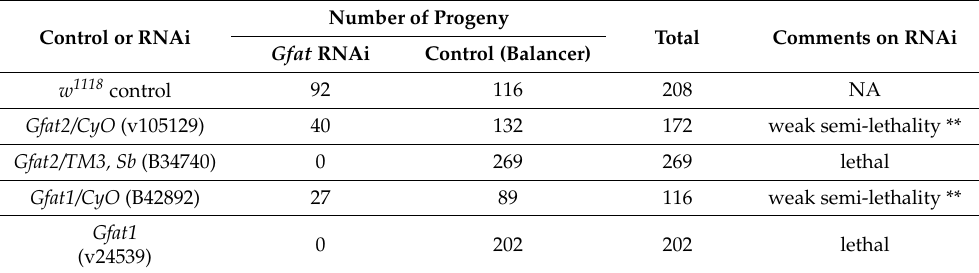
Table 5. Tests for viability effects of Gfat2 and Gfat1 RNAi knockdown in the trachea at 30 ◦ C using breathless-GAL4